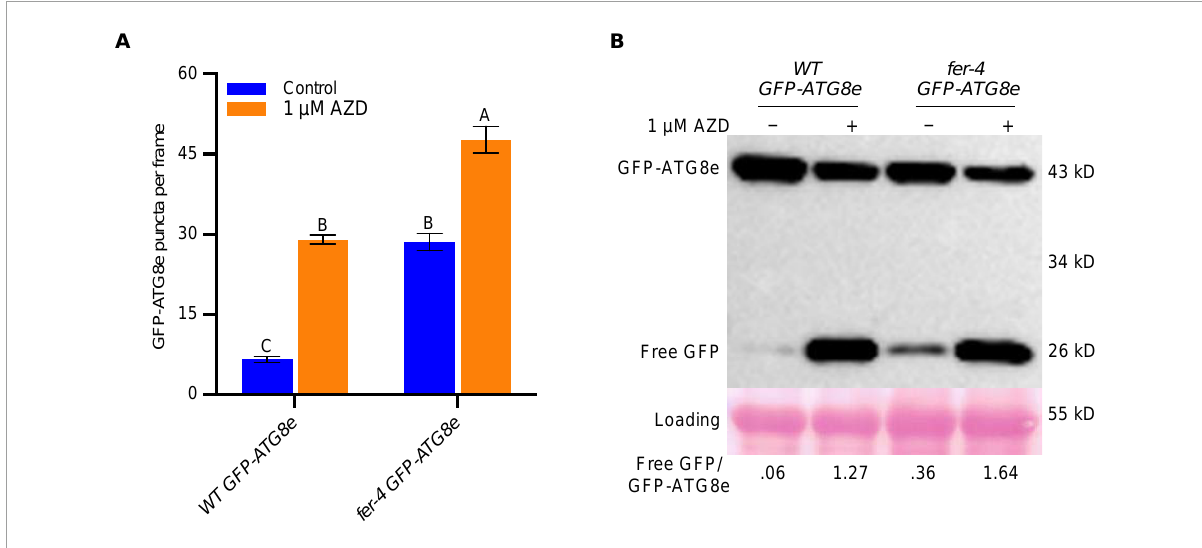
FIGURE3 FER negatively regulates autophagy under AZD8055 treatment. (A) Quantification of autophagosomes. Seven-day-old seedlings of WT GFP-ATG8e and fer-4 GFP-ATG8e grown on 1/2 LS plates were transferred to control liquid 1/2 LS or 1/2 LS with 1 µ M AZD8055 for 6 h. Data are shown as means ± SEM from 11-13 seedlings, with 2-3 images per seedlings. Different letters indicate significant difference among groups subjected to one-way ANOVA Tukey’s multiple range tests ( p < 0.05). (B) GFP-ATG8e cleavage assays of seedlings from A. The total proteins were extracted and separated by SDS-PAGE gels followed by immunoblotting with anti-GFP antibody. Ponceau S staining serves as protein loading control. The values below the blots are the ratios of free GFP over GFP-ATG8e. This experiment was carried out two times with similar